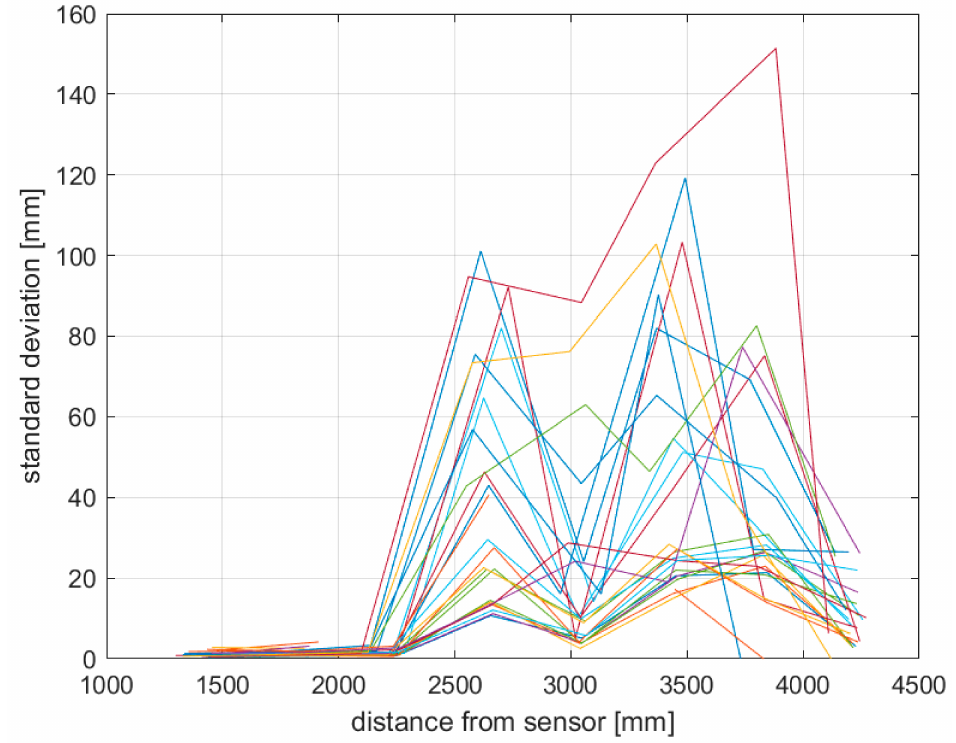
Figure 12. Body joint precision measurements of Azure Kinect in the WFOV